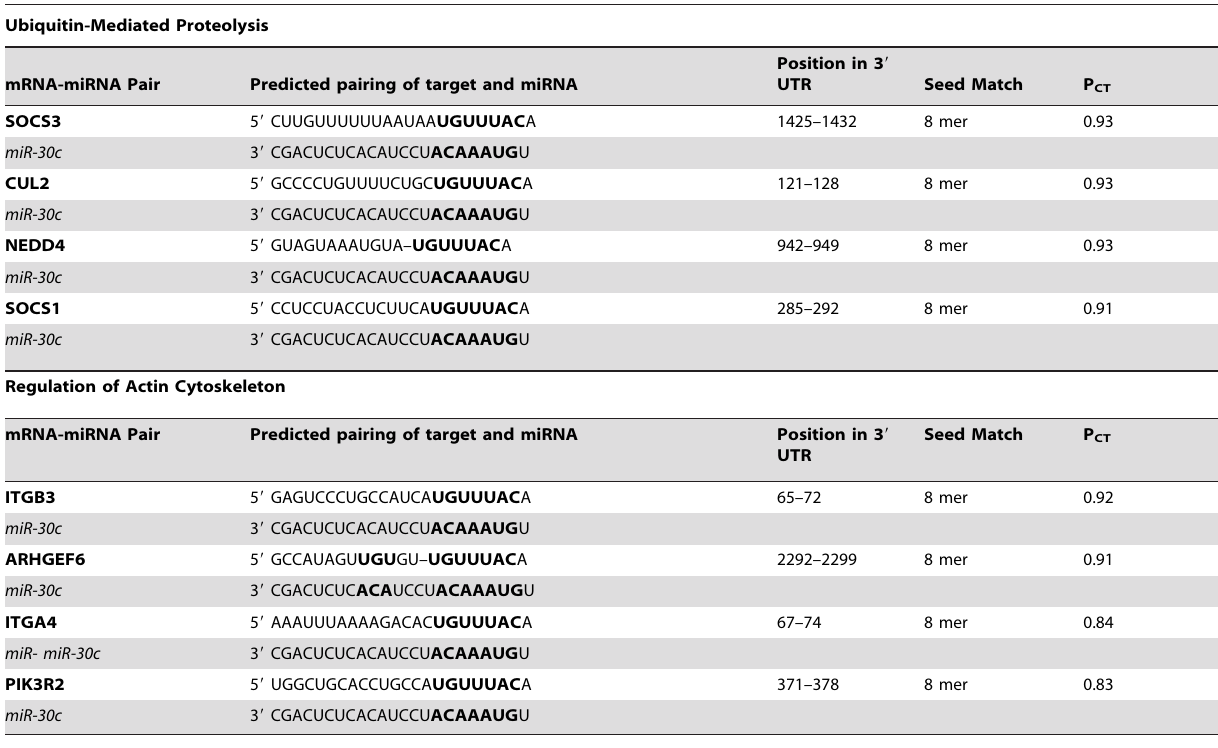
Table 2. Location of putative miR-30c binding sites in the 3 9 UTR of target mRNAs.